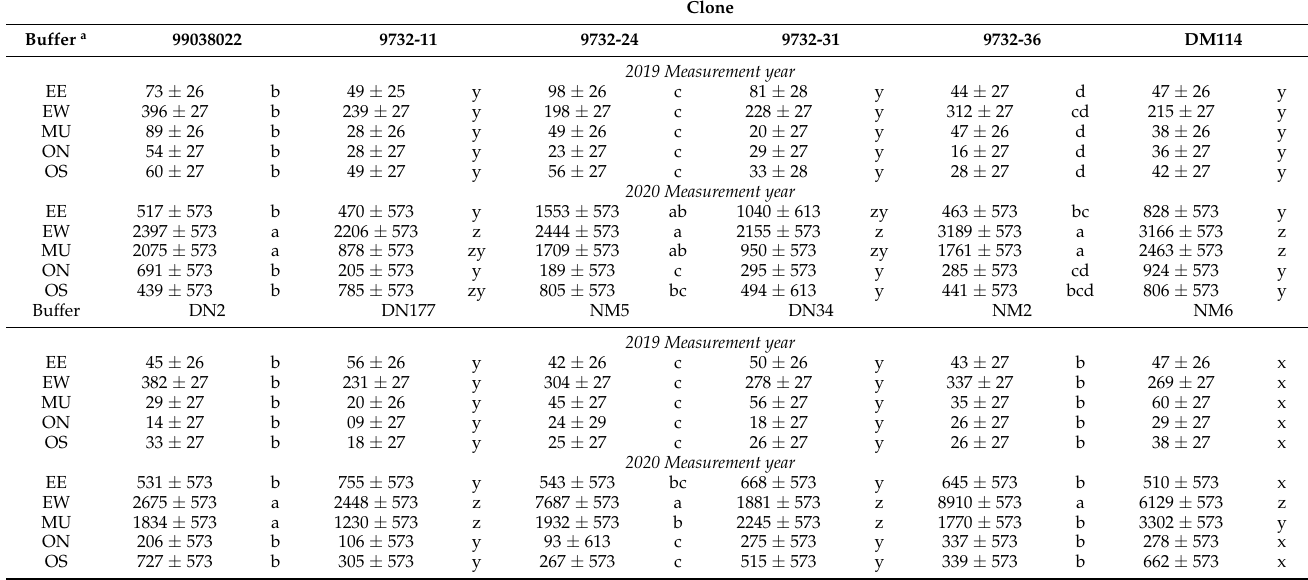
Table 7. Volume (cm 3 ) ( ± one standard error) of twelve poplar clones tested in five phytoremediation buffer systems (i.e., phyto buffers) established in 2019 (i.e., the 2019 buffer group) in the Lake Superior watershed of the Upper Peninsula of Michigan, USA. Trees were measured following the 2019 and 2020 growing seasons. Volume values with different letters within a clone column across measurement years are different at P <